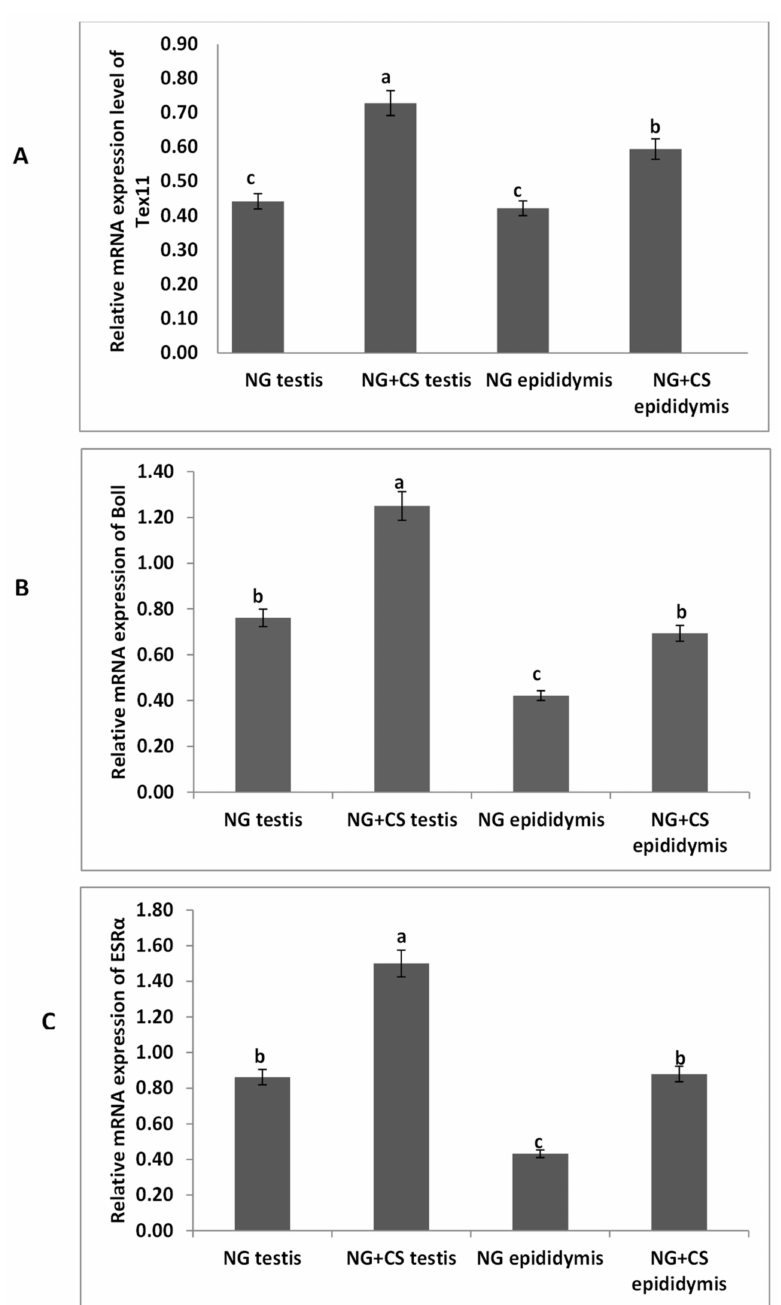
Figure 1. Expression analysis of TEX11 , BOLL , and ESR α mRNA using qPCR: ( A ) TEX11 , ( B ) BOLL , ( C ) ESR α mRNA. NG = natural grazing without concentrate supplementation group, NG + CS = natural grazing plus concentrate supplementation group. Different letters indicate a significant difference ( p <